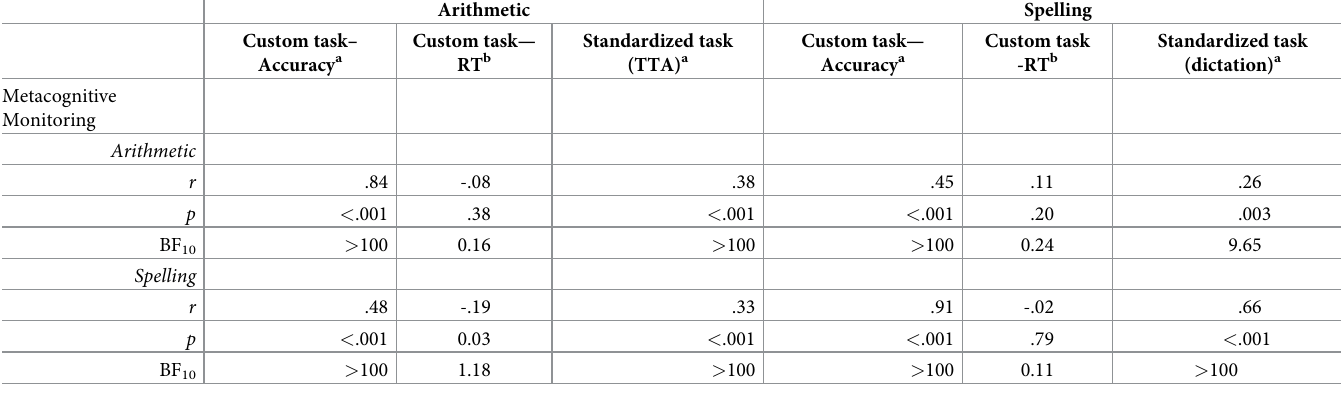
Table 1. Correlation analyses of metacognitive monitoring and academic performance measures in 8-9-year-olds (Grade